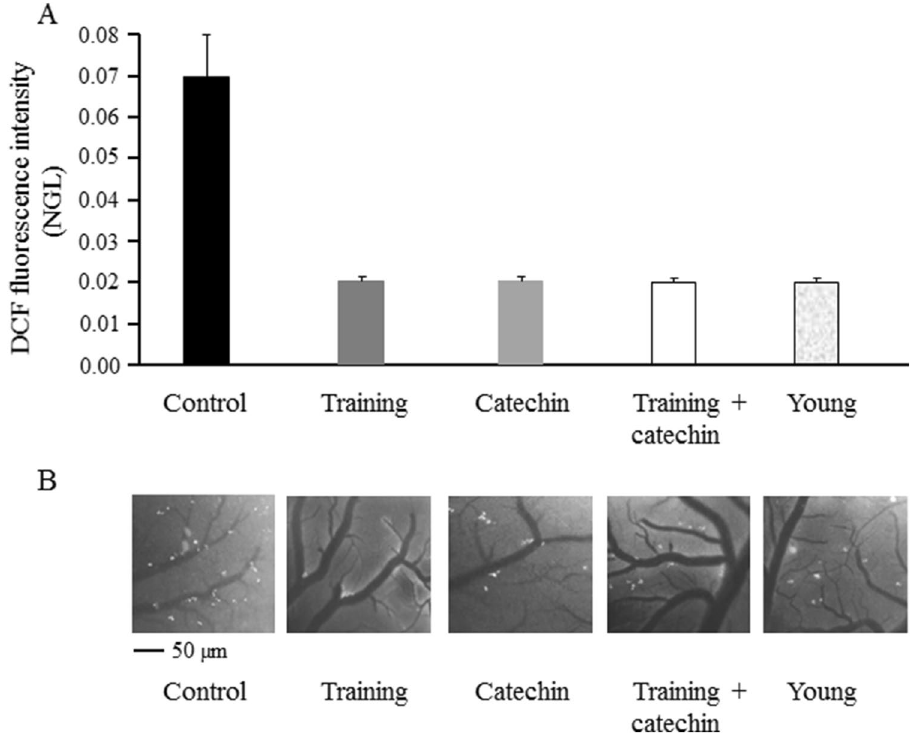
Figure 3. Evaluation of ROS formation in pial microvasculature of the parietal cortex. ROS formation was quantified by NGL ( A ). Computer-assisted images of pial microvascular networks showing fluorescence spots corresponding to the presence of ROS ( B